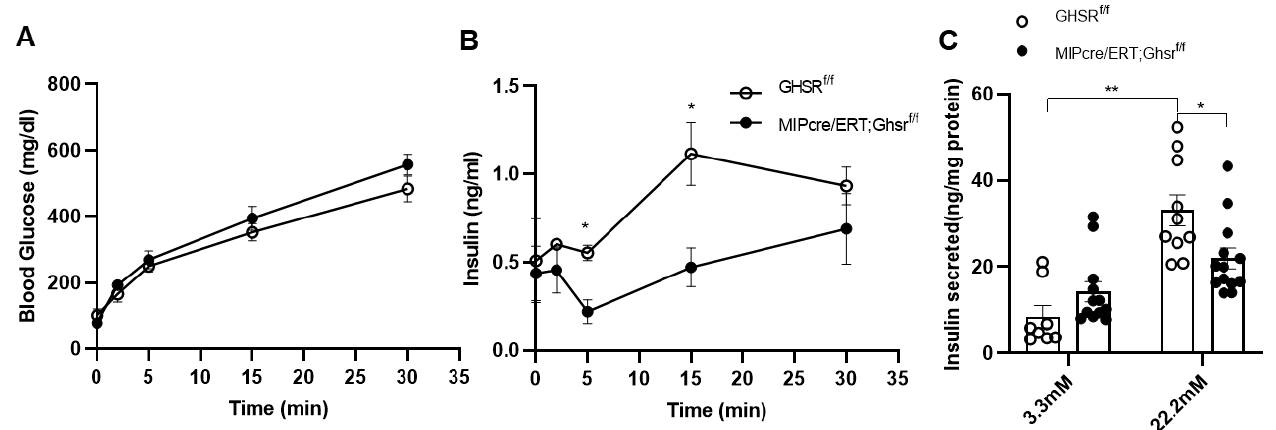
Figure 6. GHS-R ablation in β cells reduced glucose-stimulated insulin secretion. ( A , B ) Eight-month-old mice were fasted overnight, and in vivo glucose-stimulated insulin secretion (GSIS) was performed. Glucose and insulin were measured for, first, 30 min. n = 4–5. ( C ) Islets of 6-month-old Ghsr f/f and MIP-CreER;Ghsr f/f mice were treated with 3.3 mM or 22.2 mM glucose for 2 h. Insulin secretion was measured after 2 hours. The insulin levels were normalized to the total protein content of islets, n = 4–6. * p < 0.05, Ghsr f/f vs. MIP-CreER;Ghsr f/f ; ** p < 0.01, Ghsr f/f at 3.3mM vs. 22.3 nM.